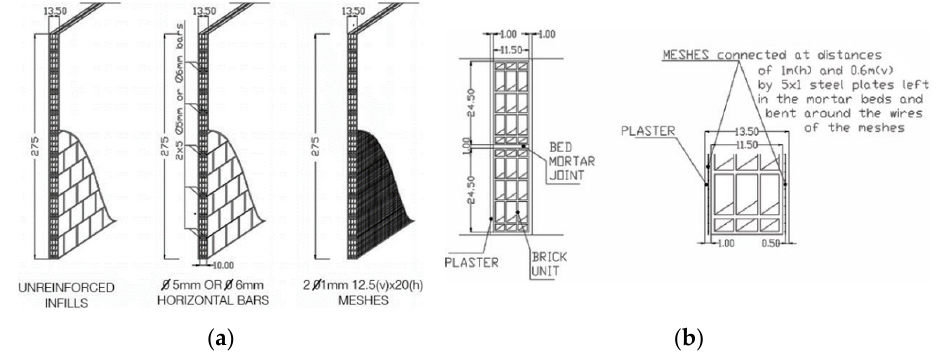
Figure 4. Models [13,14]: ( a ) infill walls; ( b ) detail of the reinforcement at the infills. The conclusions were that: (i) the presence of reinforcement lowers the damage in the infill wall but only the reinforced plaster infill increases the in-plane stiffness, energy dissipation capacity and maximum load; (ii) the in-plane damage drastically reduces the acceleration needed for the